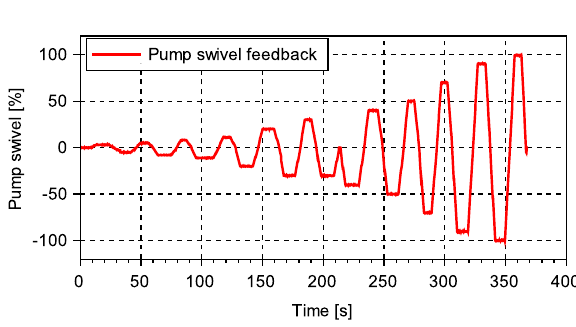
Figure 6: Typical pump displacement for a test se- quence used for determining winch friction.